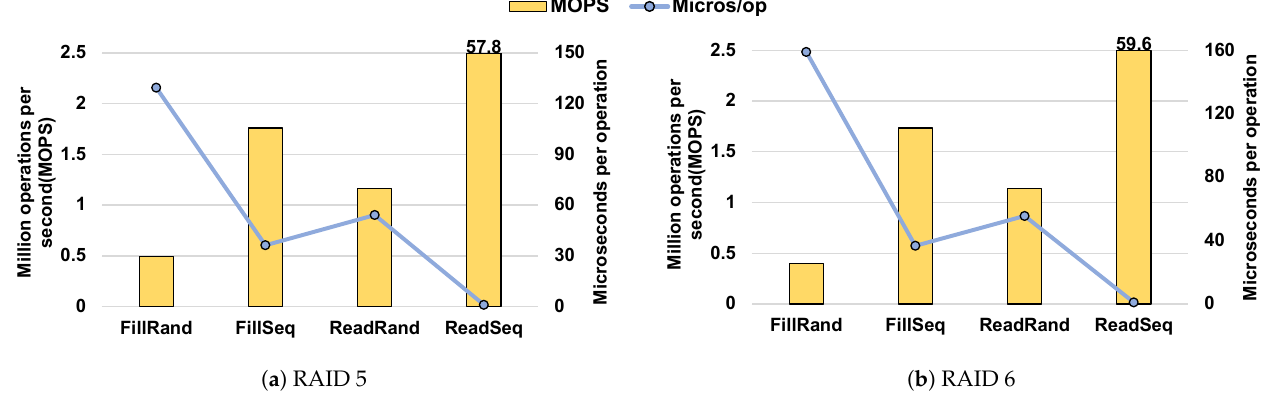
Figure 7. Experimental results under different RAID schemes (RAID 5 and 6) via DBbench. The TPC-C benchmark is a mixture of read and write (1.9:1) transactions [30] that sim- ulates online transaction processing (i.e., OLTP) application environments. We configured the user buffer size to 1 GB, page size to 16KB, flushing method to direct I/O (O_DIRECT), ramp-up time to 180 s, and execution time to 10